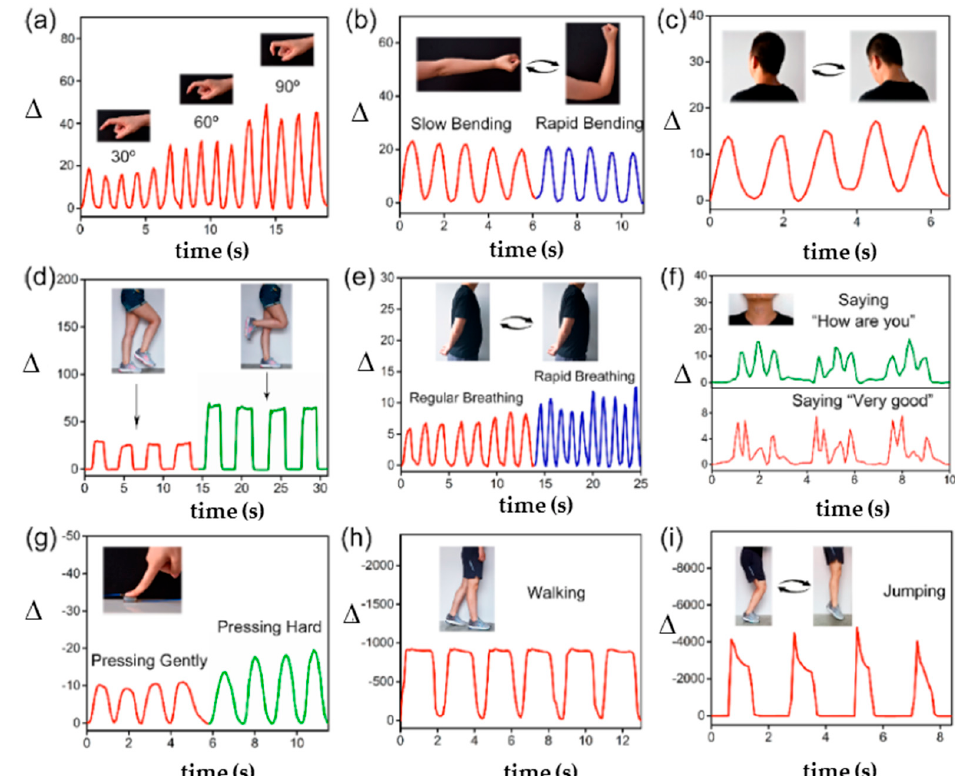
Figure 5. Illustration of the fatigue resistance for a biosensor formed by hydrophobic interactions between (P(AAm- co -LMA) and SiO 2 - g -PBA submitted to progressive increase in finger bending angles from 0° to 90° ( a ), repeated movements of the of the elbow ( b ), neck ( c ), knee ( d ), during breathing ( e ), speaking (phonation recognition) ( f ), applied pressure ( g ), walking ( h ) and jumping ( i ). Adapted with permission from Ref. [149. Xia, S.; Zhang, Q.; Song, S.; Duan, L.; Gao, G. Bioin- spired dynamic cross-linking hydrogel sensors with skin-like strain and pressure sensing behav- iors. Chem. Mater . 2019 , 31 , 9522–9531. https://doi.org/10.1021/acs.chemmater.9b03919], Copyright 2019, American Chemical Society.